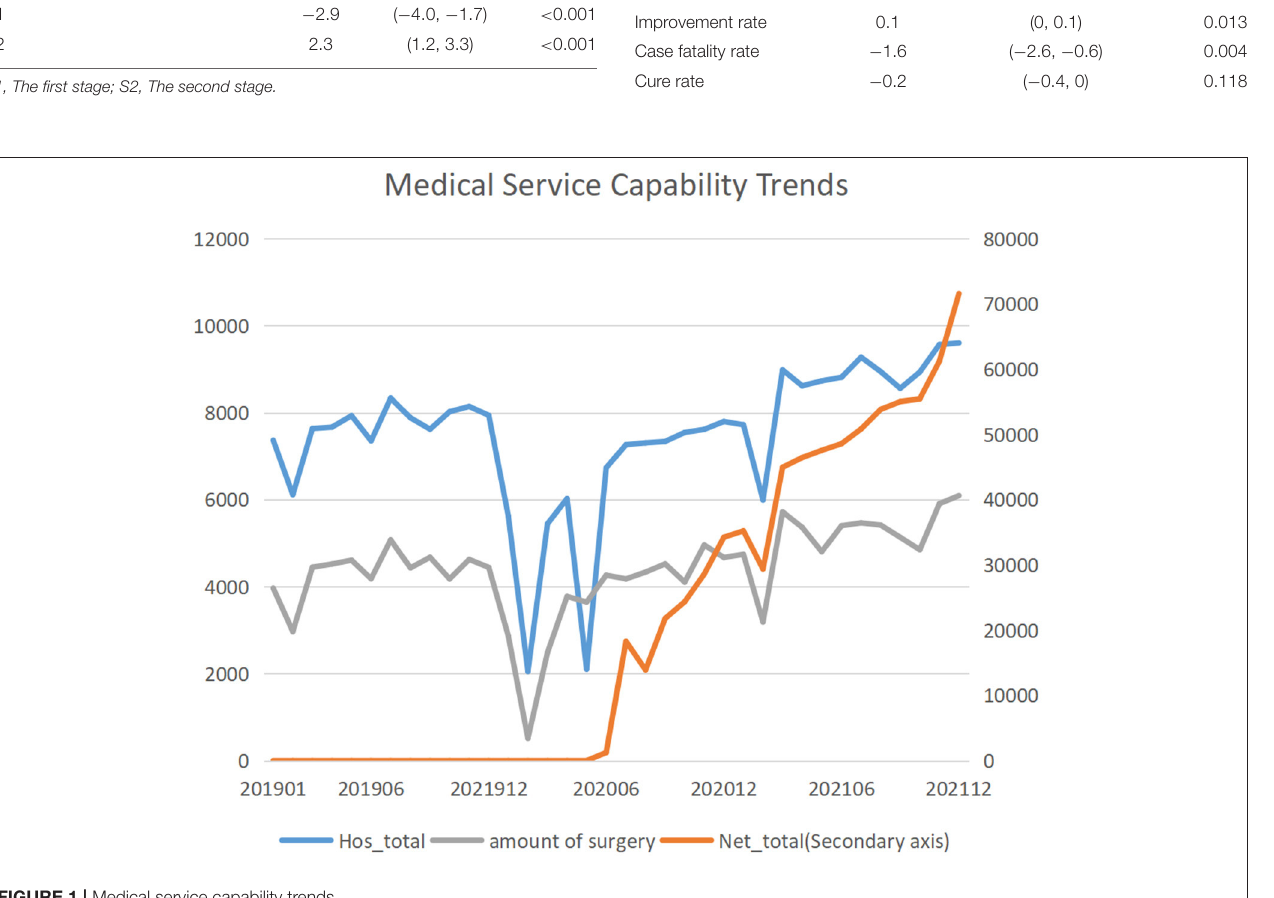
FIGURE 1 | Medical service capability